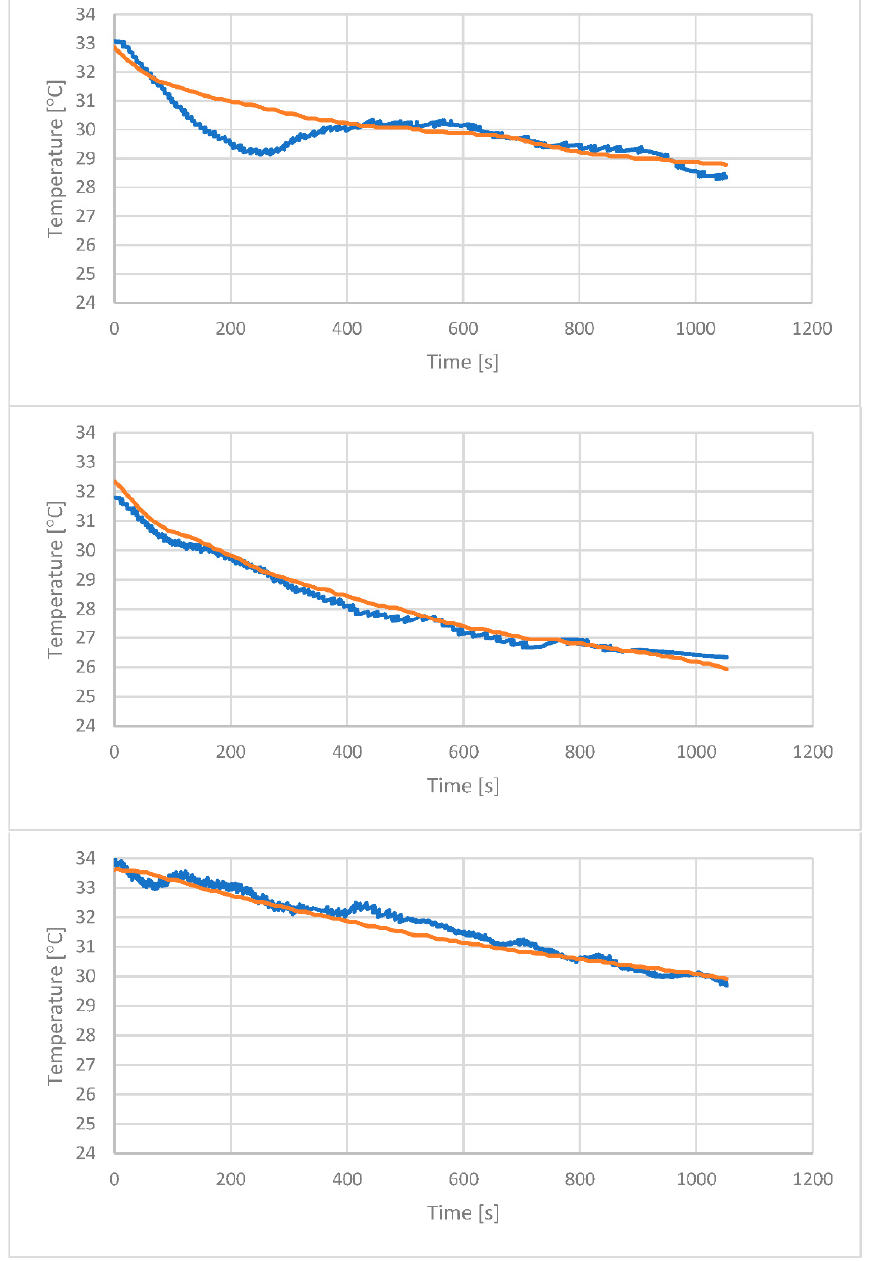
Figure 12. Reference (orange) and computed (blue) skin temperatures. From top: participant A, B and C . Note different time scale than in Figure 7.